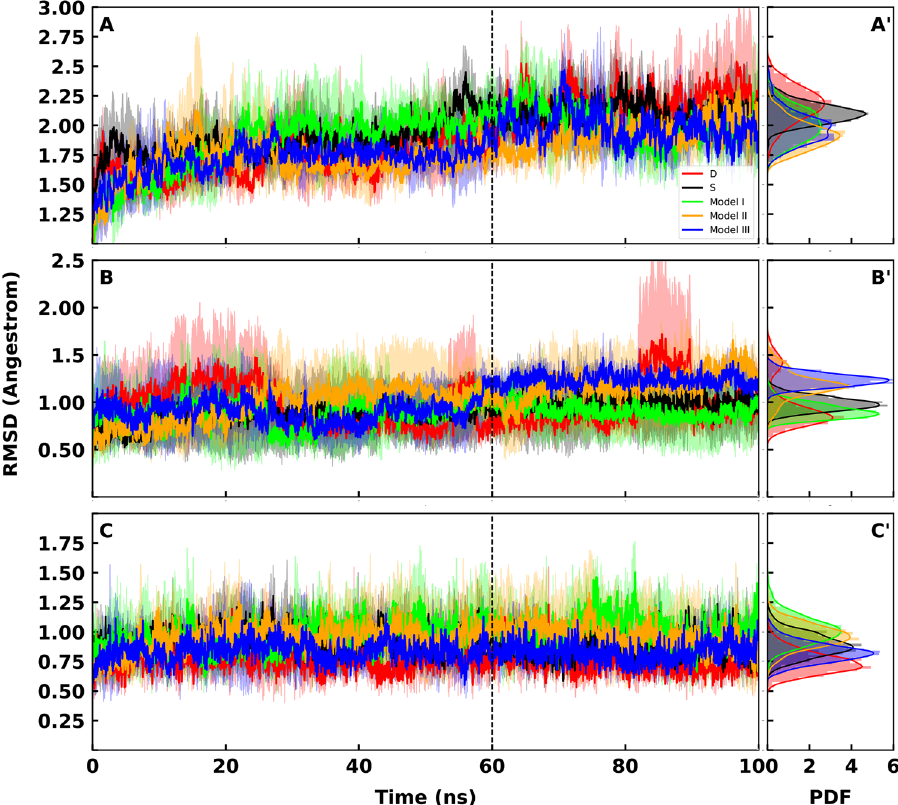
Figure 7. ( A ) Average backbone RMSD plots for ACE2 calculated from all replicates of each system and are shown for model S (black), model I (lime), model II (orange) and model III (blue). Light shades around each plot presents standard error for each calculation. RMSD of model D is shown in red. ( A ’) Probability Density Function (PDF) of RMSD sampled over the last 40 ns (dashed line) of the simulations are shown in histograms. ( B ) Average backbone RMSD plots for α -Helix1 calculated from all replicates of each system and are shown for model S (black), model I (lime), model II (orange) and model III (blue). Light shades around each plot presents standard error for each calculation. RMSD of model D is shown in red. ( B ’) Probability Density Function (PDF) of RMSD sampled over the last 40ns (dashed line) of the simulations are shown in histograms. ( C ) Average backbone RMSD plots for α -Helix2 calculated from all replicates of each system and are shown for model S (black), model I (lime), model II (orange) and model III (blue). Light shades around each plot presents standard error for each calculation. RMSD of model D is shown in red. ( C ’) Probability Density Function (PDF) of RMSD sampled over the last 40 ns (dashed line) of the simulations are shown in